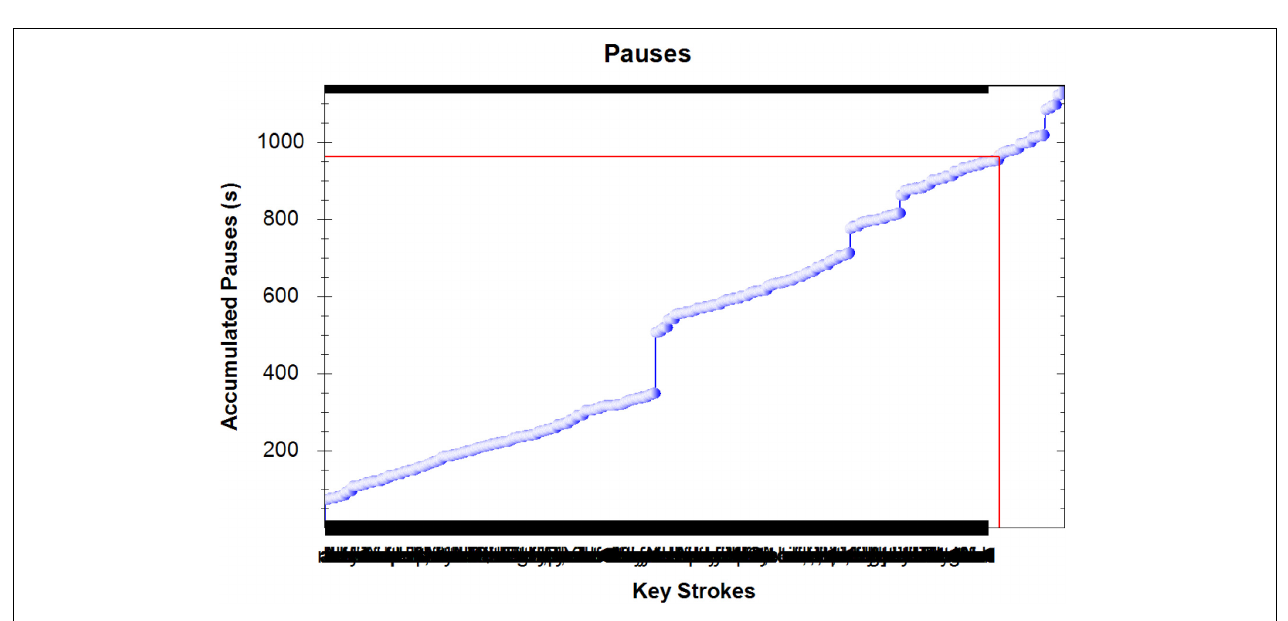
FIGURE 5 | Pauses plot in the translation of a media